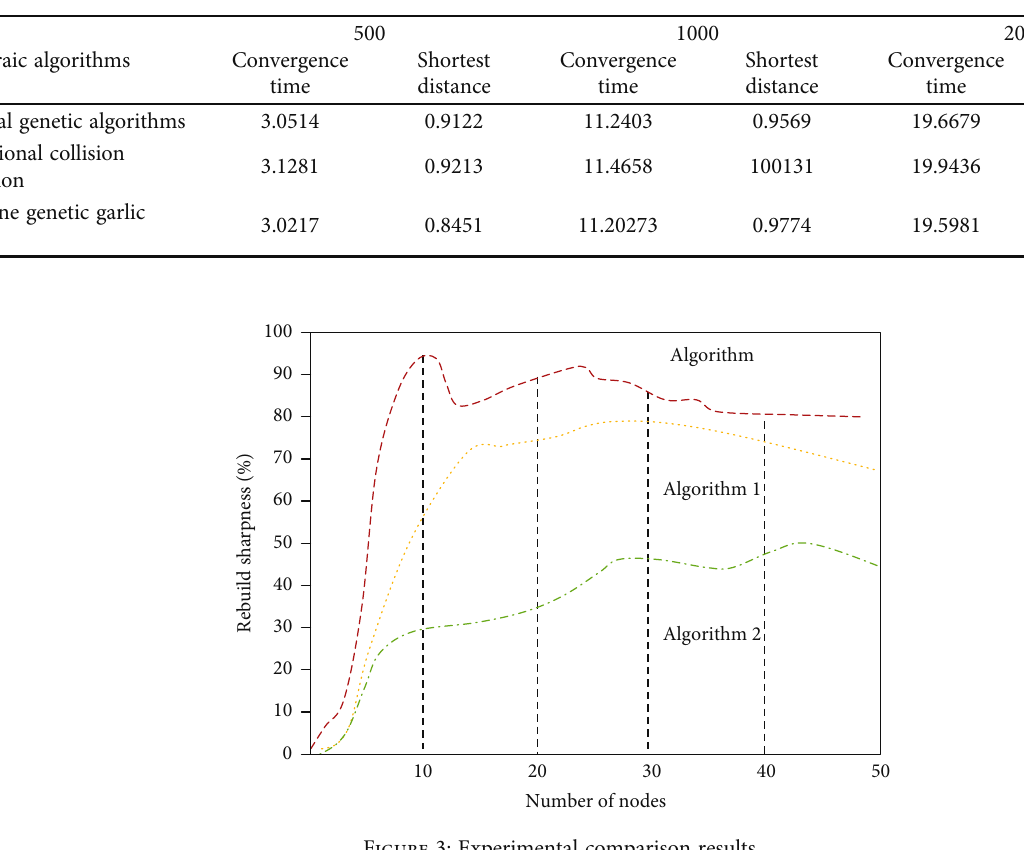
Table 4: The simulation results of the algorithm with 200, 400, and 800